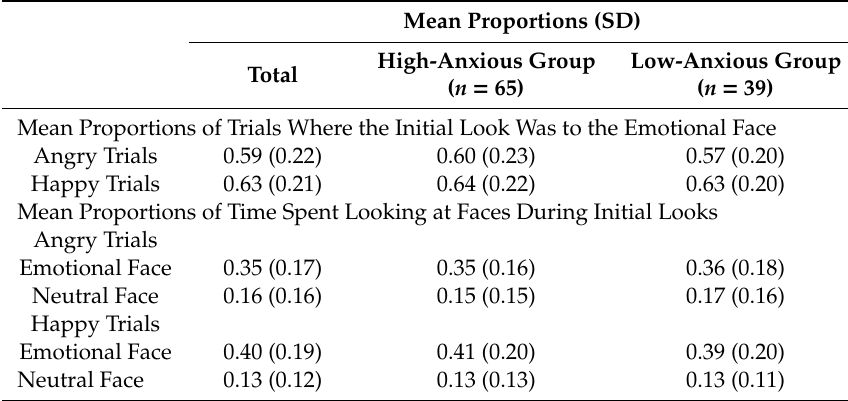
Table 1. Summary statistics of initial looks to the faces by anxiety